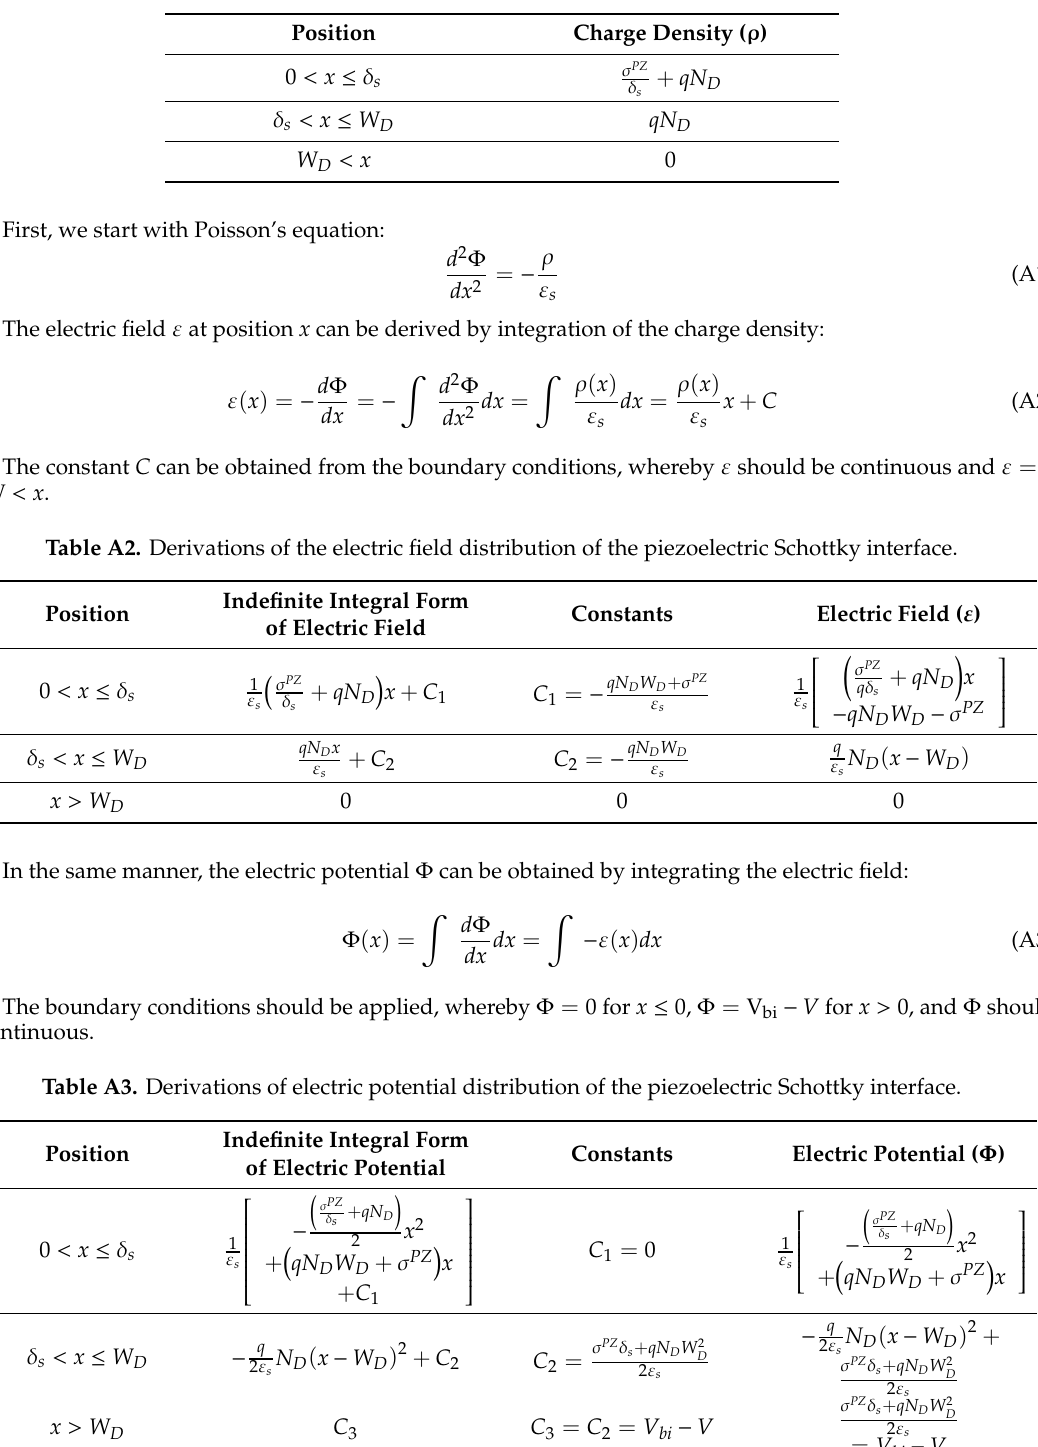
Table A1. Charge density distribution of the piezoelectric Schottky interface.